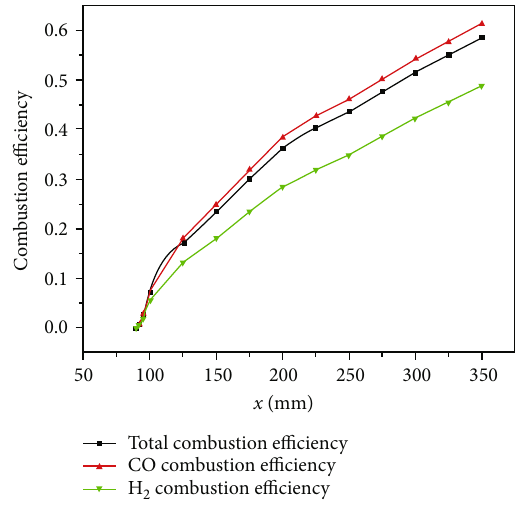
Figure 25: Combustion e ffi ciency.